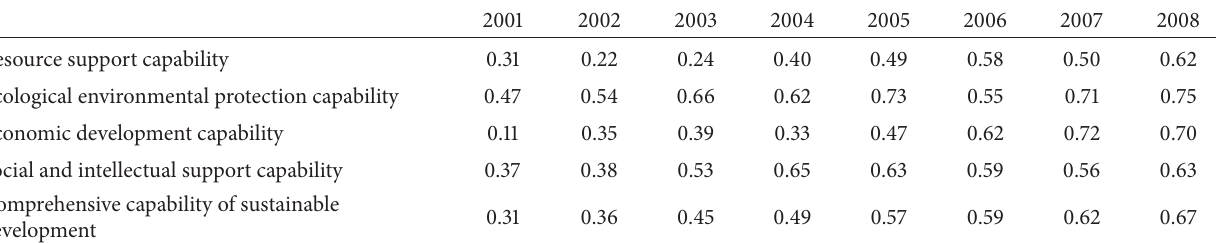
Table 2: The synthetic evaluation indexes of sustainable development systems of Changhai